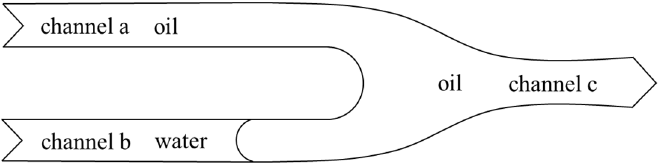
Figure 10. Schematic diagram of the capillary inhibition effect between the parallel channels. Dif- ferent flow paths are distinguished by a-c. ent flow paths are distinguished by a–c.